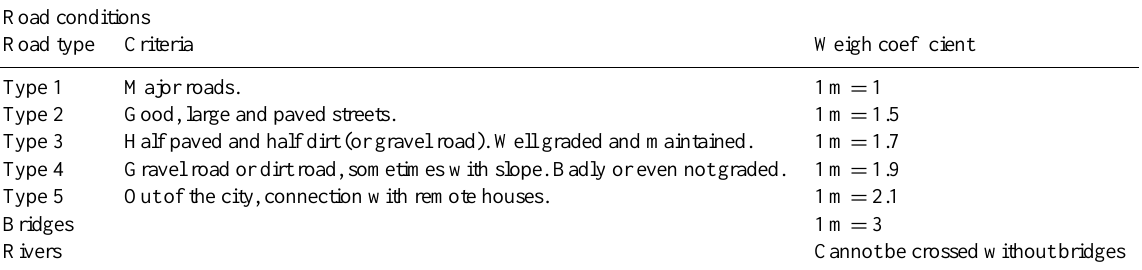
Table 6b. Road conditions. Starting from the computation of the isolation index (II), the mapping takes into account road conditions and natural constraints (rivers and bridges). Poor road conditions result in additional travel time to facilities and an increase in